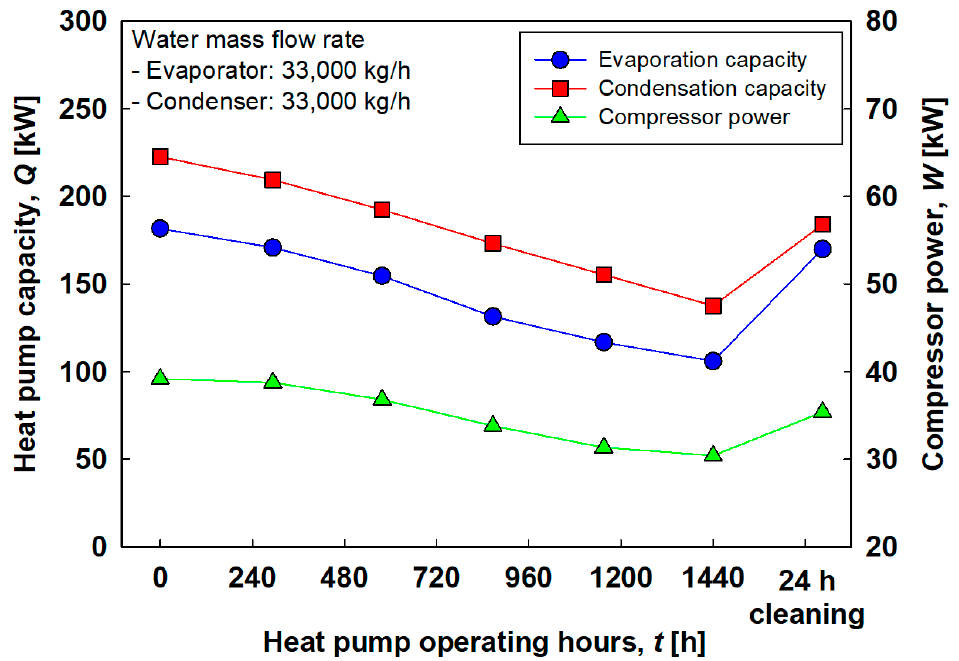
Figure 13. Variation of heat pump capacity and compressor power consumption according to heat pump operating hours.